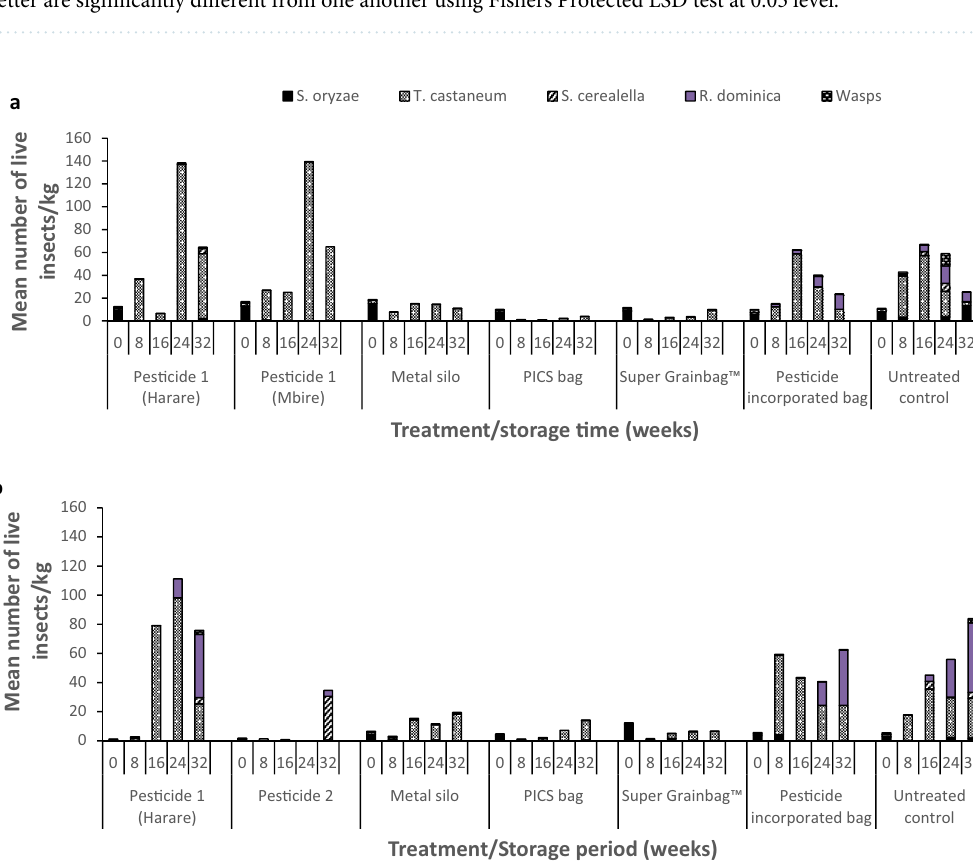
Figure 3. Mean total number of live storage insects per kg of sorghum grain sample in Mbire district, Zimbabwe during: ( a ) the 2014/15 and ( b ) the 2015/16 storage seasons (n = 8). Pesticide 1 = fenitrothion 1% + deltamethrin 0.13%; Pesticide 2 = pirimiphos-methyl 0.16% + thiamethoxam 0.036%; Pesticide- incorporated bag = deltamethrin-incorporated polypropylene bag at 3